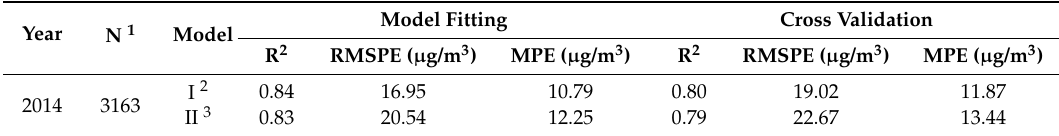
Table 2. Model performance summary for MOD-3K AOT.